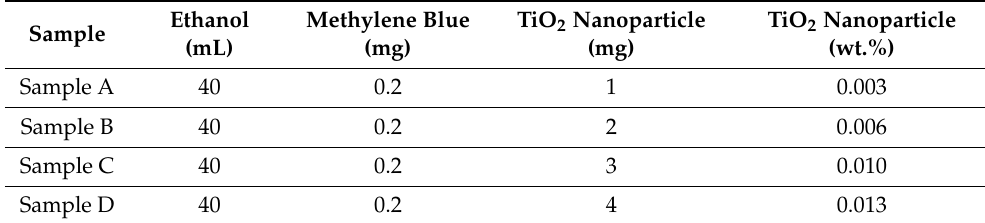
Table 1. Four different MB samples with TiO 2 nanoparticle